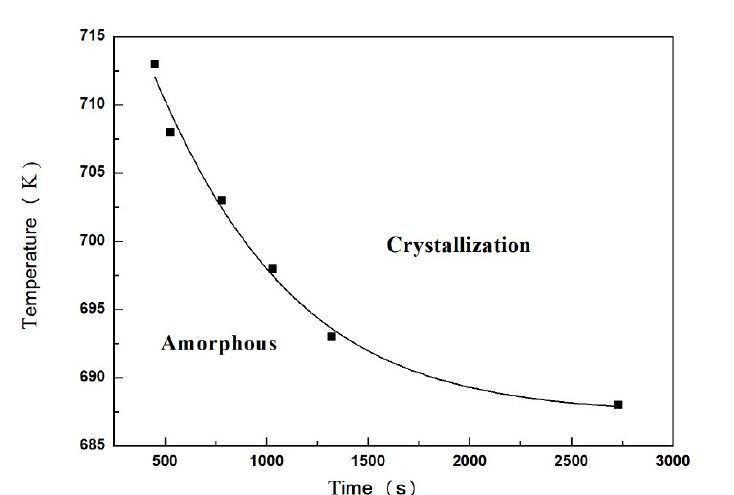
6. Figure 6. Isothermal DSC curves at various temperatures for the W particles/Zr 41.2 Ti 13.8 Cu 12.5 Ni 10 Be 22.5 metallic glass matrix composite.